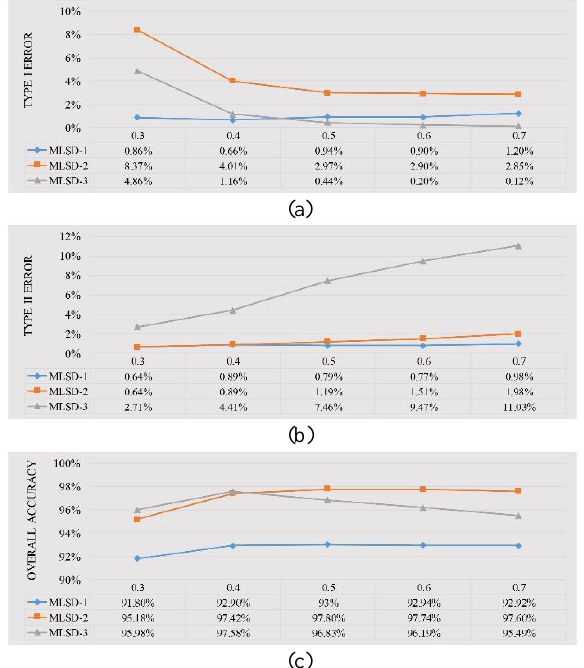
Fig. 6 Sensitivity tests with the global elevation threshold ( h g ): (a) Type I error, (b) Type II error, and (c) Overall accuracy Finally, we used Γ b = 5.0 m, Γ v = 5.0 cm, and h g = 0.5 m and varied h e from 4.0 m to 10.0 m with an interval of 1.5 m.